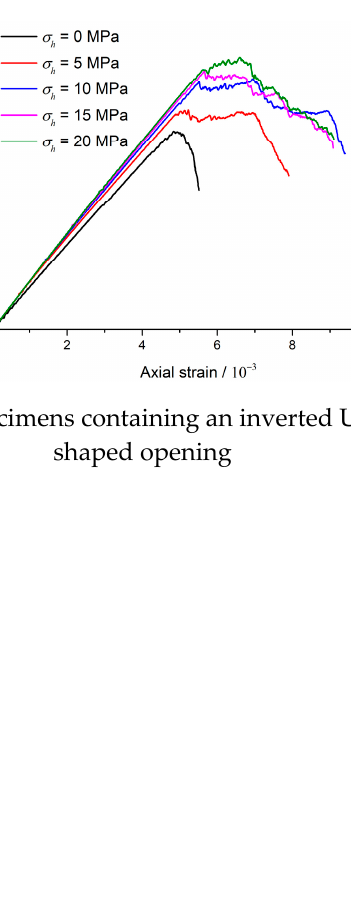
Figure 12. Axial stress-strain curves for specimens with different openings.